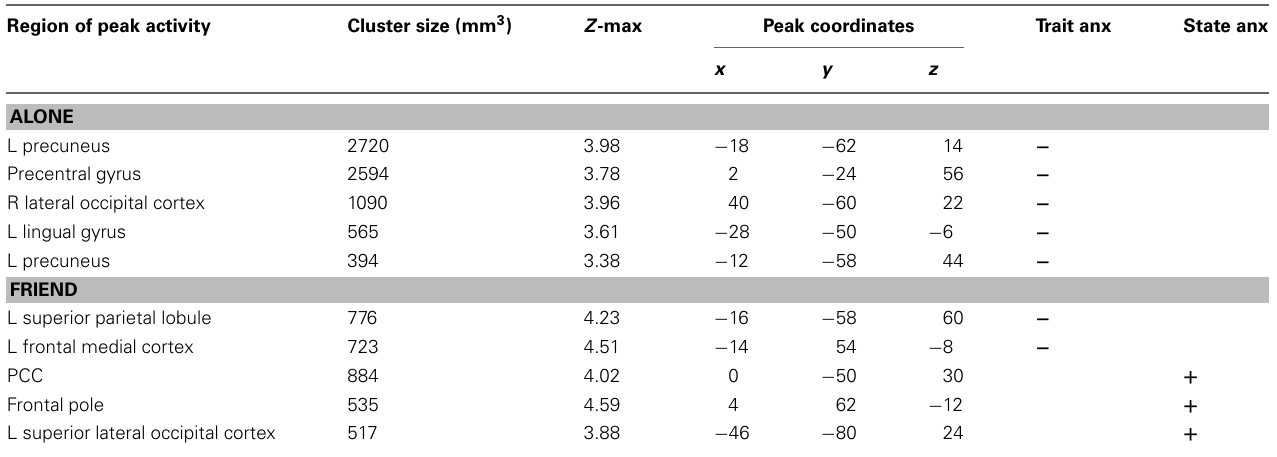
Table 1 | Main effects of trait/state anxiety levels, by condition. Region of peak